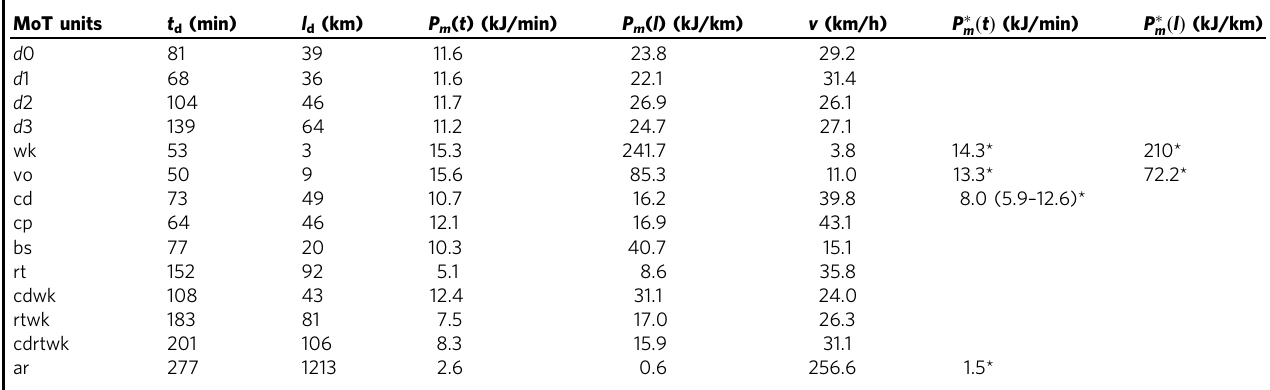
The calculated values are given as overall averages, the measured values from Spitzer et al. (1982) are marked with *.